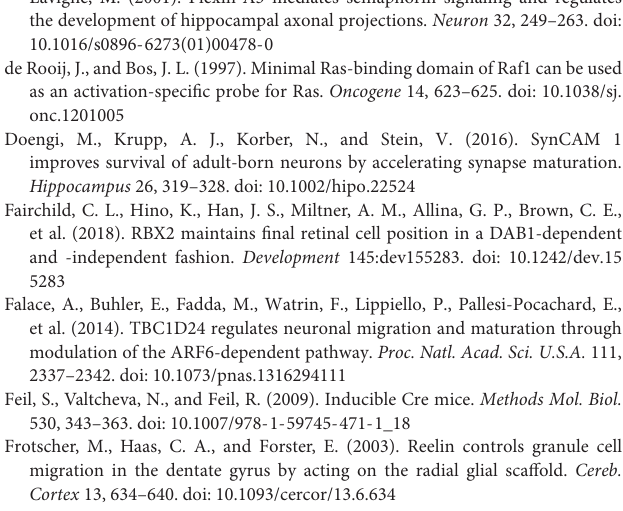
Supplementary Figure 2 | pY-DAB1 and DAB1 accumulation levels in RBX2 and SOCS7 mutant models. (A) DAB1 stainings in P21 control (RBX2 fl/fl), RBX2cKO-Emx1, SOCS7–/–, RBX2cKO-Emx1; DAB1+/– DG, and DAB1–/–. (B,C) Western blotting of P10 control and Rbx2cKO-Emx1 (B) and SOCS7–/– (C) hippocampal lysates. Red arrowhead indicates pY-Dab1. Supplementary Figure 3 | (A) Decreased number of EdU + cells survived in the RBX2 mutant DG in comparison to control. Mean ± SEM. Statistics, unpaired Student’s t -test. (B) Representative images of control and tamoxifen-dependent depletion of RBX2 in NSCs does not promote adult neurogenesis. Mean ±